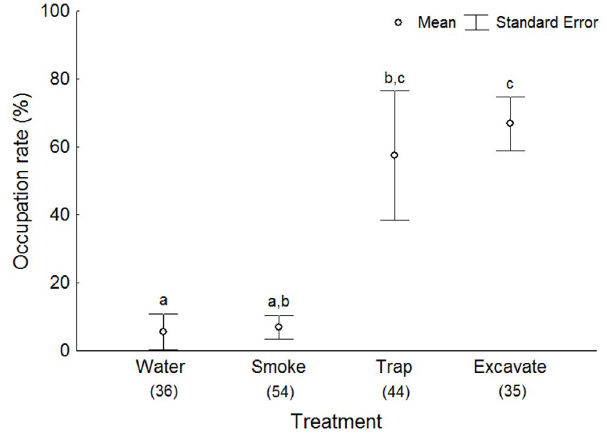
Figure 6. Occupation detected by means of different treat- ments. Mean and standard error of occupation rate of Ocypode quadrata burrows, determined by means of water, smoke, trapping and excavation methods, at Arpoador Beach in August 2012. Different letters denote significant differences discriminated by Tukey test. The number of burrows assessed for each treatment is shown in parentheses below the x axis.